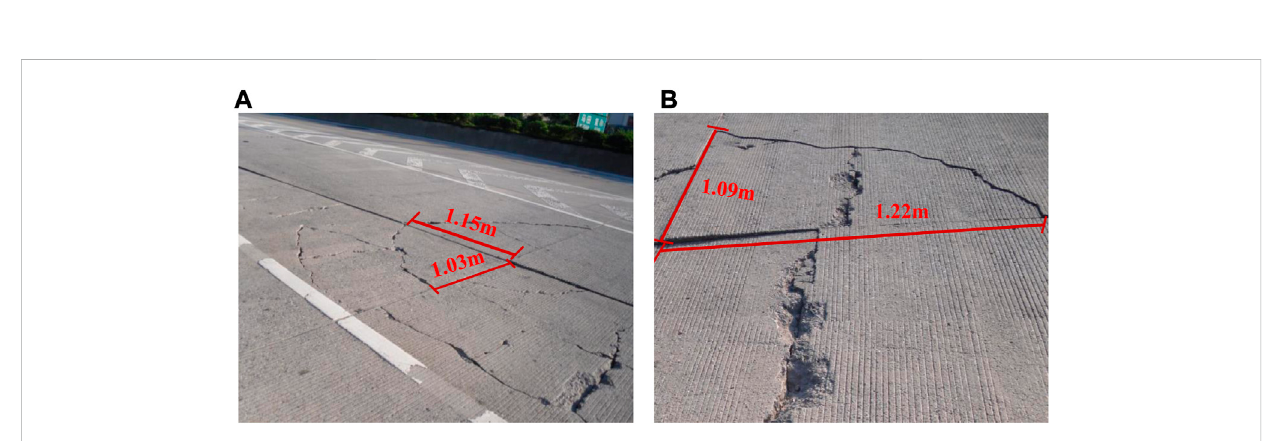
FIGURE 11 Field cracking investigation of the concrete pavement: (A) point 1; (B) point